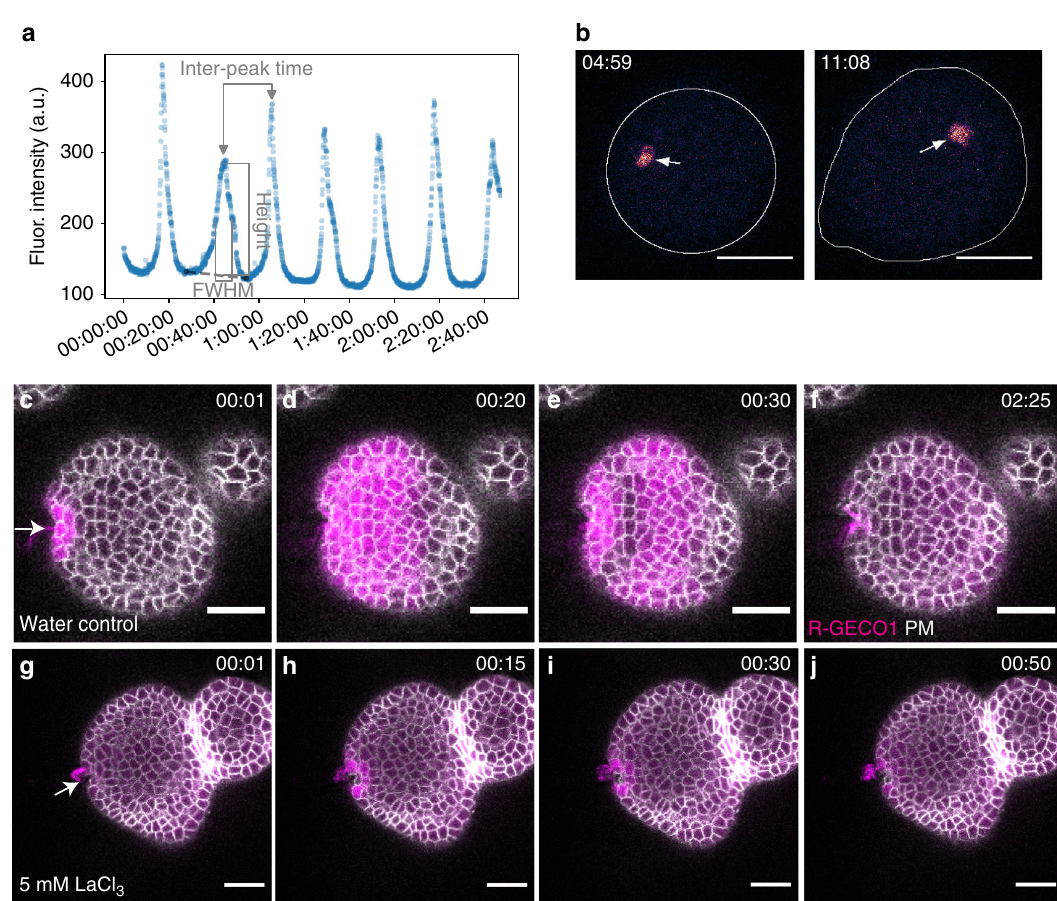
Fig. 3 Three different types of Ca 2 + signal in the Arabidopsis SAM. Ca 2 + signals in the SAM include two spontaneous Ca 2 + patterns ( a , b ), and calcium waves that are activated by mechanical stimuli ( c – f ). a Global meristematic transient Ca 2 + levels, as measured by the mean fl uorescence intensity level taken over a region-of-interest in the SAM, and plotted as function of time, showing regular peaks. The inter-peak time and the full width at half maximum (FWHM) are annotated in the panel, as well as the baseline (dashed gray line) and peak height. b Two representative Ca 2 + spike images. Arrow points to a cell showing a spike signal. The contour line delineates the border of the SAM. LUT is gem in Fiji-ImageJ software. c – f Representative frame images of R- GECO1 (magenta) and membrane marker 29 – 1 fused to GFP (gray) in the SAM, in response to mechanical stimulus from a glass pipette at the side of the SAM. g – j Effects of a 15-min pretreatment with 5 mM LaCl 3 on Ca 2 + wave transmission in the SAM. Arrow points to the direction of pipette prodding. Scale bars: 20 µ m ( b - j